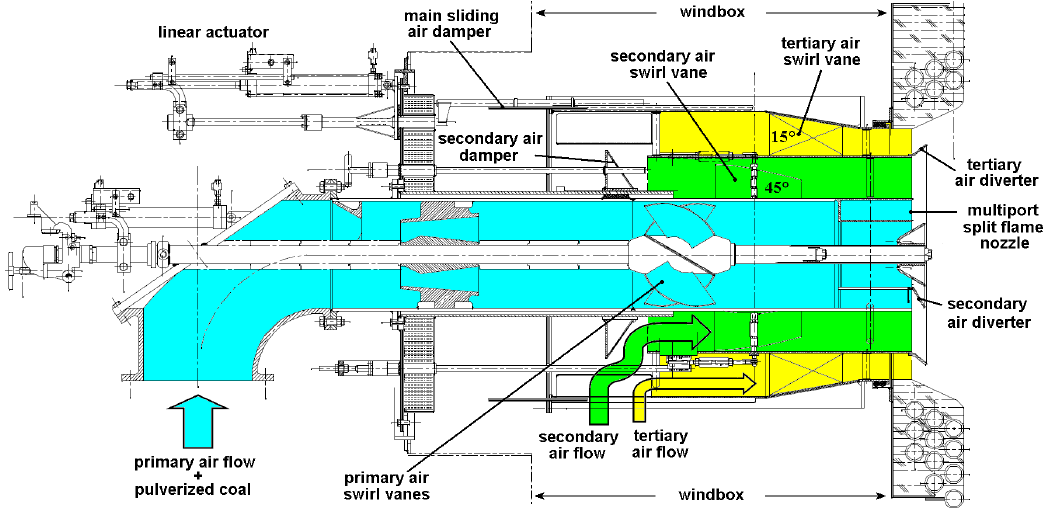
Figure 1. Three air flux coal burner.